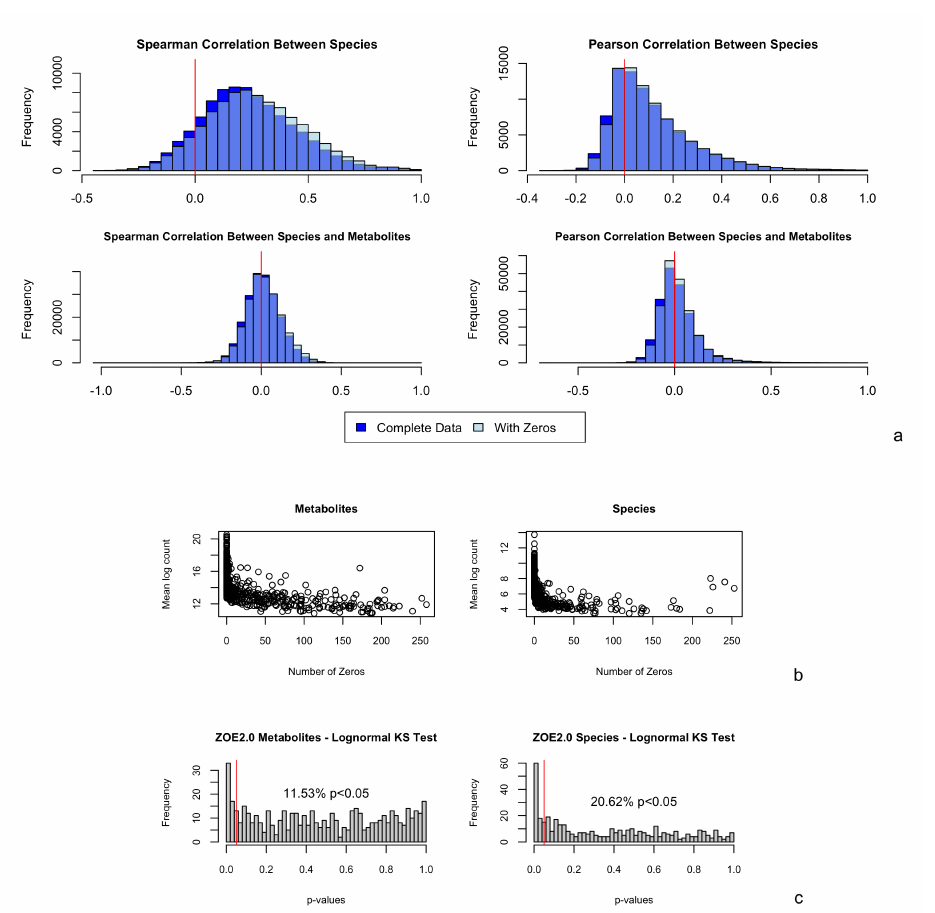
Figure 1. ( a ) Observed Spearman and Pearson correlations between pairs of (Kraken2/Bracken) species (417); and between pairs of (Kraken2/Bracken) species (417) and metabolites (503); in ZOE 2.0 (n = 289). Correlations among complete data exclude subjects with one or more zeros in the pair; correlations among data with zeros include all subjects. The red vertical line in each plot represents a correlation of 0. ( b ) Number of zeros plotted against mean log nonzero count for each metabolite and number of zeros plotted against mean log nonzero count for each Kraken2/Bracken species. ( c ) p -values obtained from lognormal (parameters from models fitted on nonzero counts for each metabolite and species) Kolmogorov–Smirnov test for ZOE 2.0 metabolites and Kraken2/Bracken microbiome species. The red vertical line represents a p -value of 0.05 so that p -values below it indicate statistical significance in the